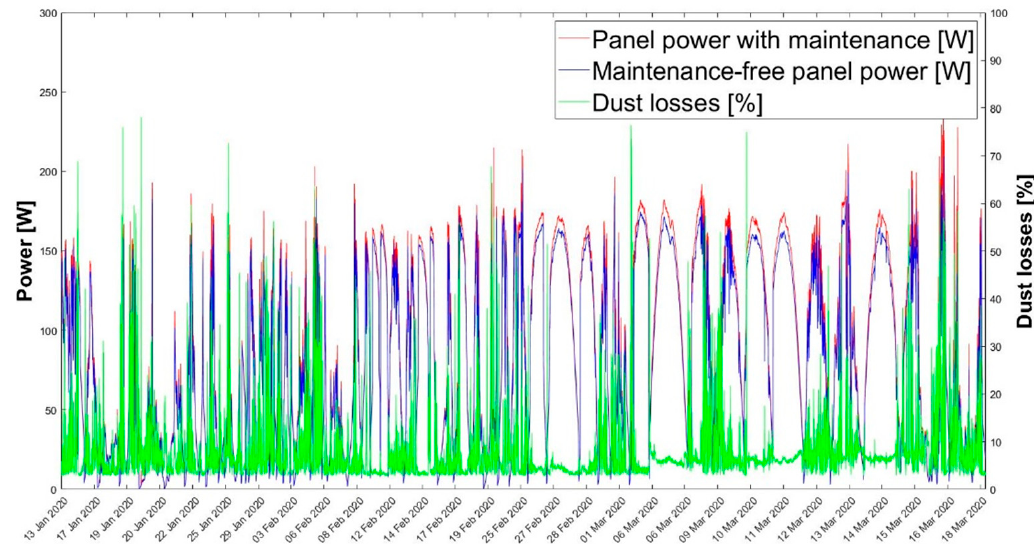
Figure 5. Variation in power and power loss.